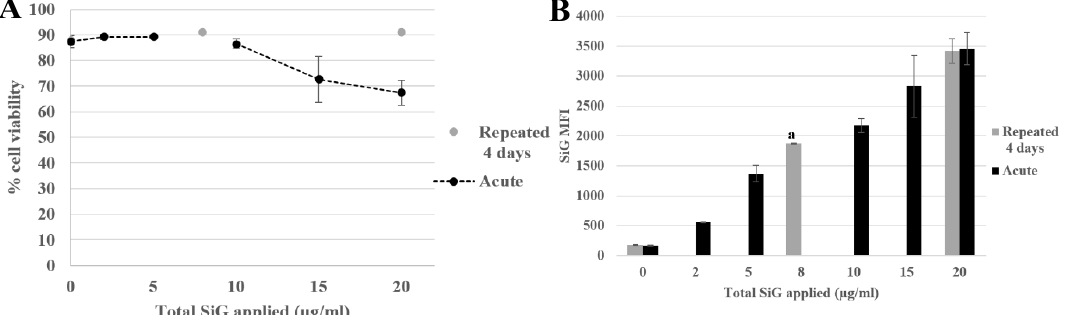
Figure 2. 4-day exposure repeated exposure of RAW264.7 cells to SiO 2 NP compared with acute exposure, by flow cytometer. ( A ) Viability assay of SiG exposed cells measured with propidium iodide. ( B ) Green silica (SiG) internalization. (a: repeated 2 µ g/mL versus acute 5 and 10 µ g/mL, p -value < 0.05).